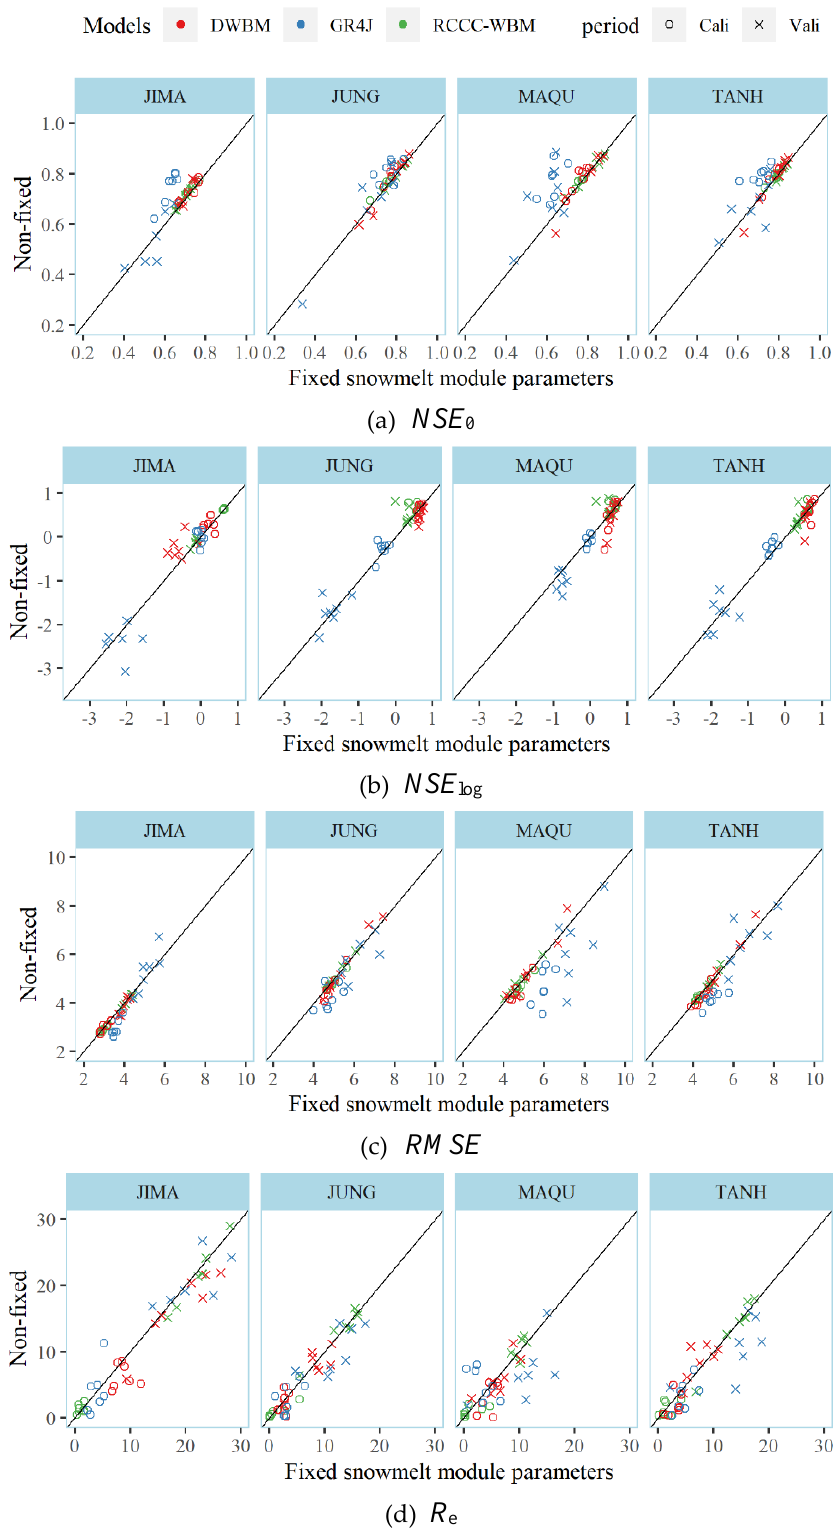
Figure 11. Comparison of performance indices ( a ) NSE 0 , ( b ) NSE log , ( c ) RMSE , and ( d ) R e between the simulated and observed monthly streamflow from the simulation results, using the DWBM, RCCC-WBM, and the GR4J model with fixed and non-fixed snowmelt module parameters in model calibration, based on the SCE-UA algorithm (the black line is the 1:1 reference curve).